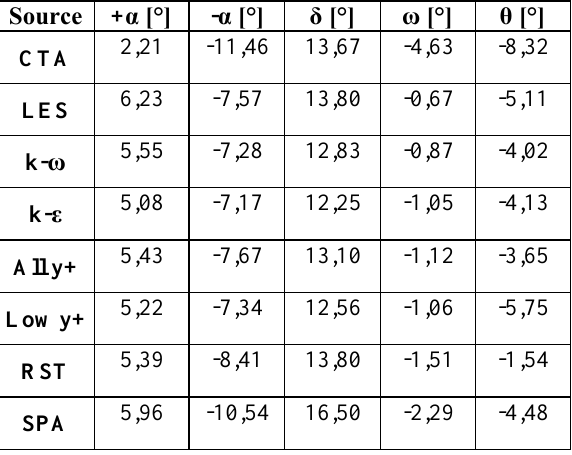
Table 1. The direction angles for the horizontal plane